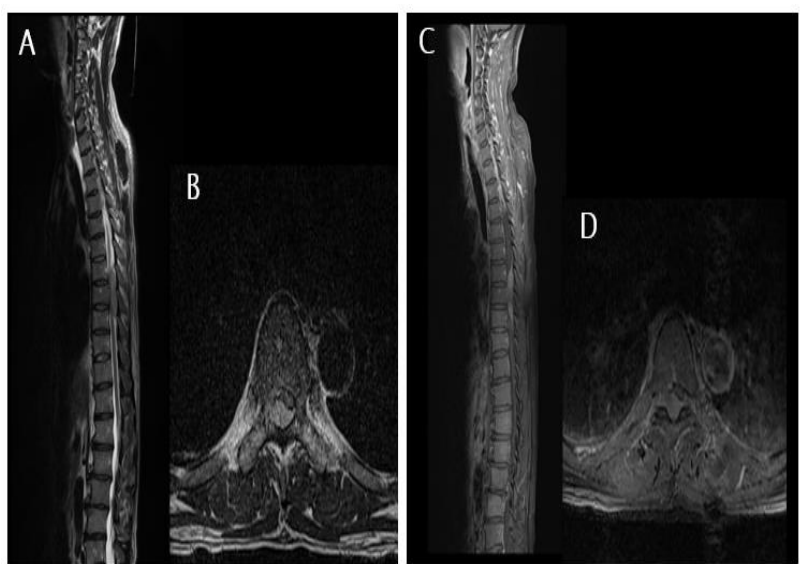
Figure 1. Magnetic resonance images of the patient. ( A , B ) T2-weighted sagittal and axial images showing an epidural mass lesion compressing the spinal cord from T7 to T9. ( C , D ) Contrast-enhanced magnetic resonance images reveal homogeneous enhancing epidural lesions at T7–T9 levels.